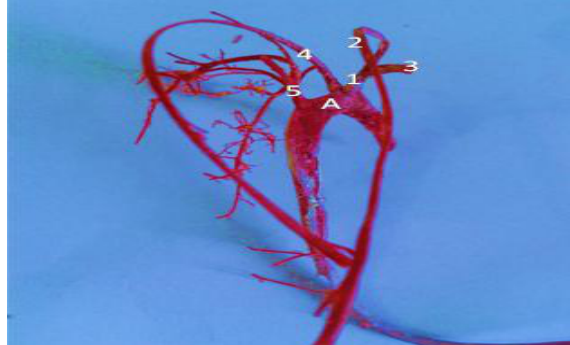
Figure, 3: The cast of the aortic arch and it's major branches in rabbits (dorsal view) showing (A) Aortic arch (1) Brachiocephalic trunk (2) right common carotid artery (3) Right subclavian artery (4) left common carotid artery (5) left subclavian artery.